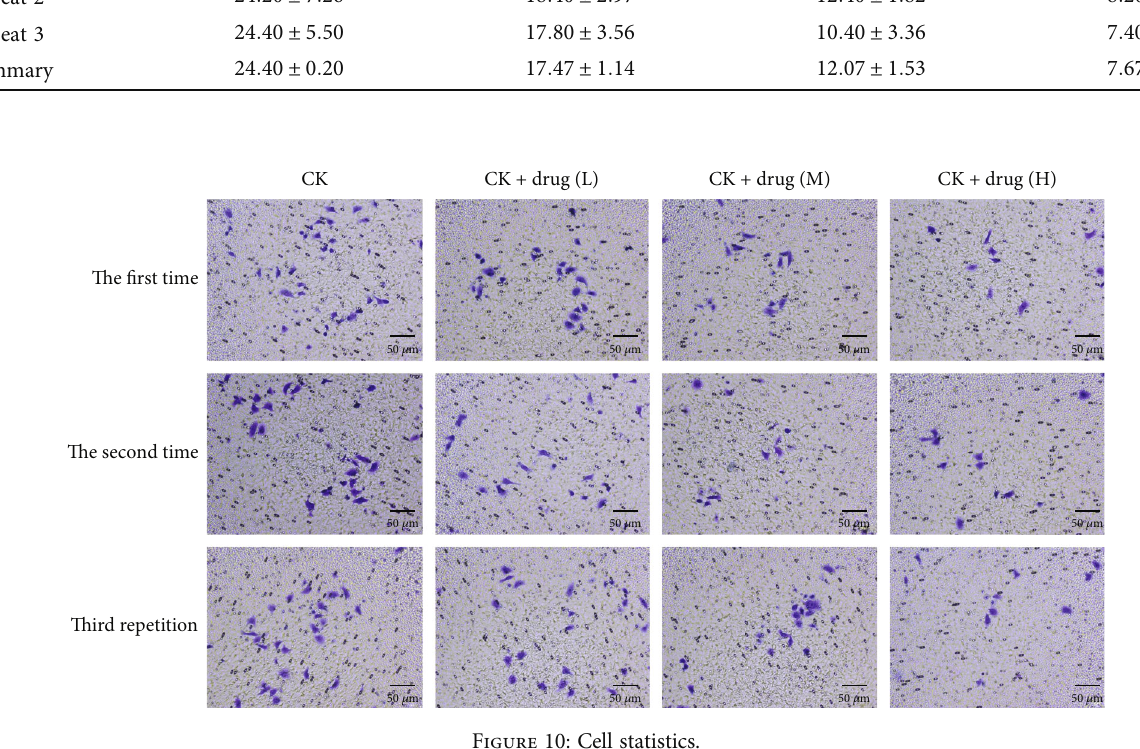
Figure 10: Cell statistics.